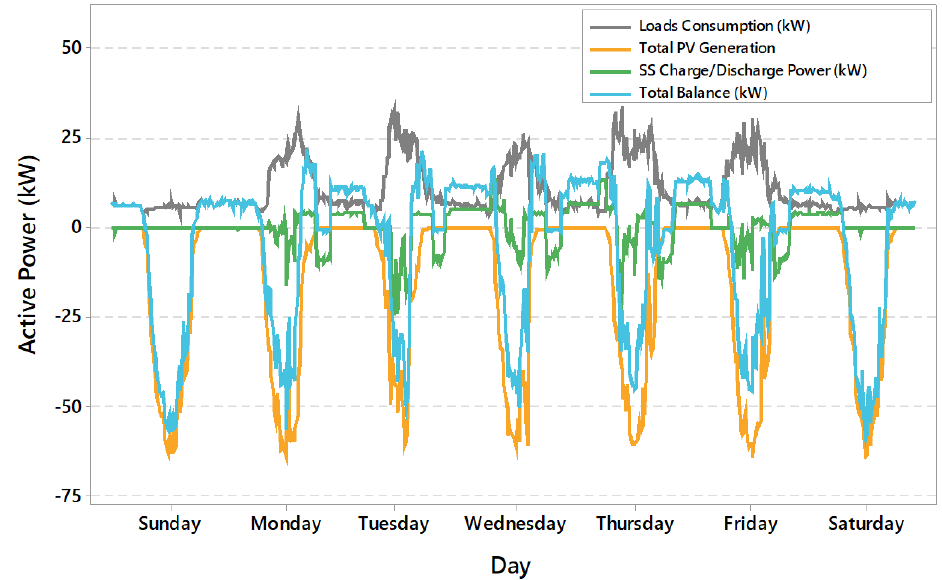
Figure 21. Total power balance for mini power plant